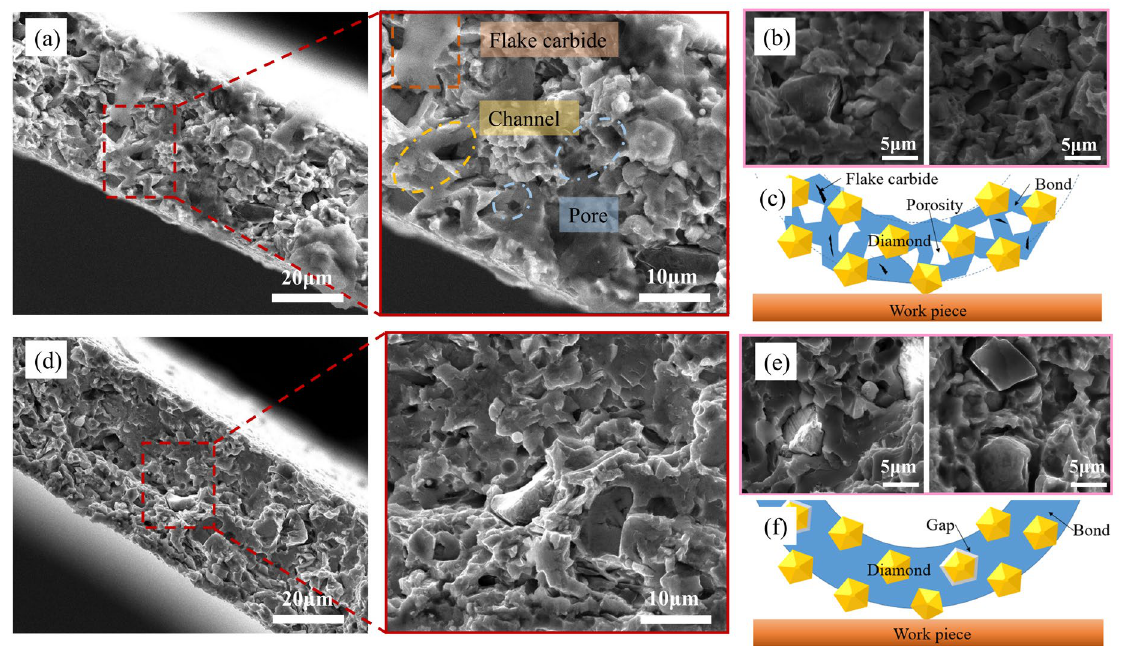
Figure 6. Microstructure of the dicing blades with different forming methods; ( a – c ) Rolling-slitting; ( d – f ) Cold pressing.